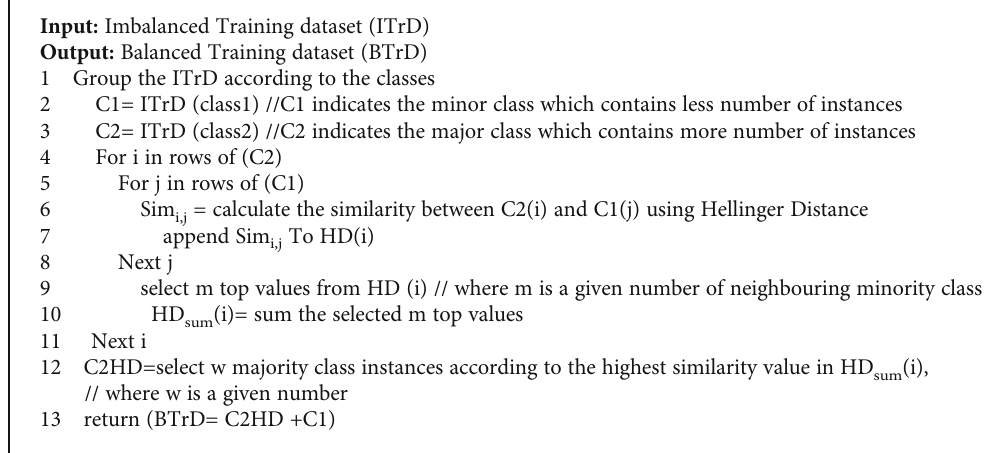
Algorithm 1: Hellinger Distance Undersampling (HDUS) pseudocode Table 1: The features of colorectal cancer dataset. No.